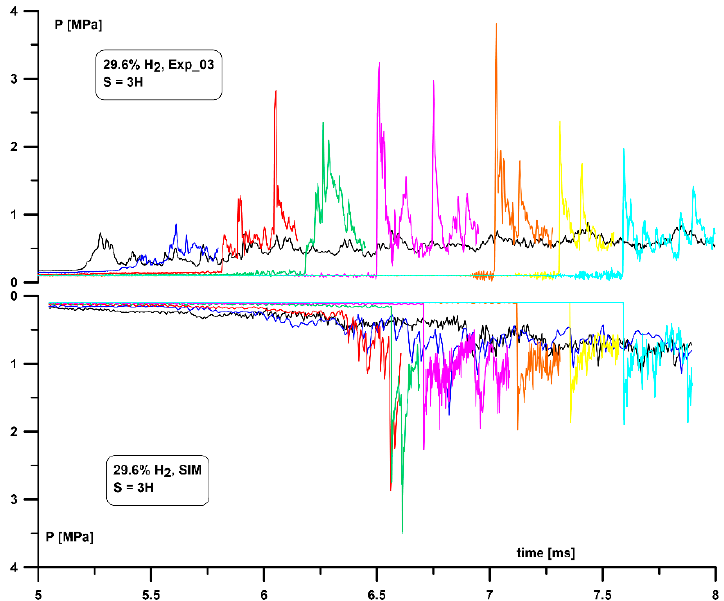
Figure 14. Experimental ( top ) and numerical ( bottom ) pressure profile with detonation for case S = 3H and 29.6% H 2 in air. Sequence of sensors activation corresponds to the sensors position as in Figure 1. Same colors apply to sensors in the same position. Simulation time shifted − 1.0 ms for better visibility.